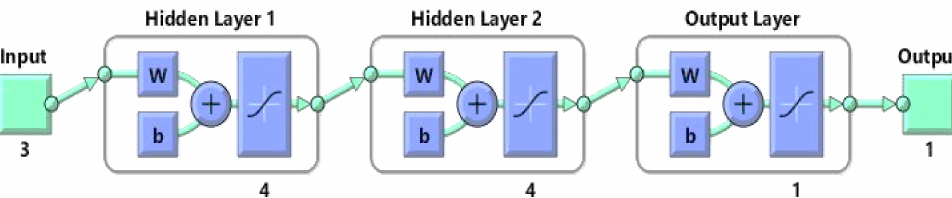
Figure 4. Best network topologies with the Bayesian regulation training algorithm for prediction of antioxidant activity (DPPH).